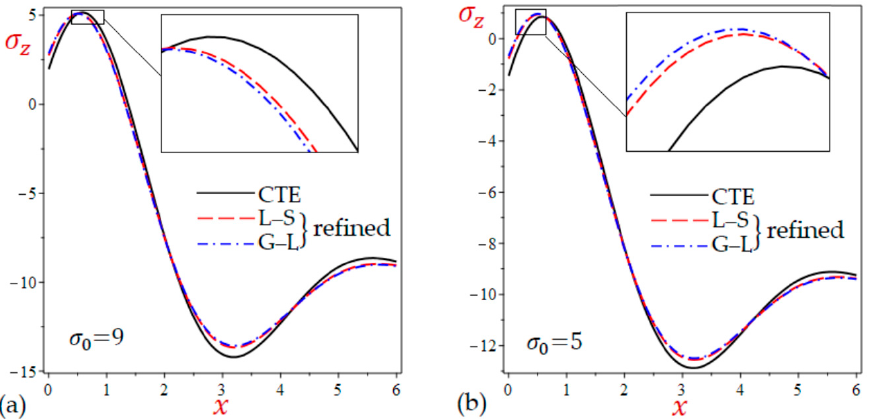
Figure 5. Effect of initial stress σ 0 on the transverse normal stress σ z of the rotating half-space with Figure 5. Effect of initial stress 𝜎 (cid:2868) on the transverse normal stress 𝜎 (cid:3053) of the rotating half-space initial pressure ( (cid:112) = 10) ( a ) σ 0 = 9; ( b ) σ 0 = with initial pressure ( 𝓅 = 10 ) ( a ) 𝜎 (cid:2868) = 9 ; ( b ) 𝜎 (cid:2868) = 5 . Figure 5. Effect of initial stress 𝜎 (cid:2868) on the transverse normal stress 𝜎 (cid:3053) of the rotating half-space with initial pressure ( 𝓅 = 10 ) ( a ) 𝜎 (cid:2868) = 9 ; ( b ) 𝜎 (cid:2868) = 5 .